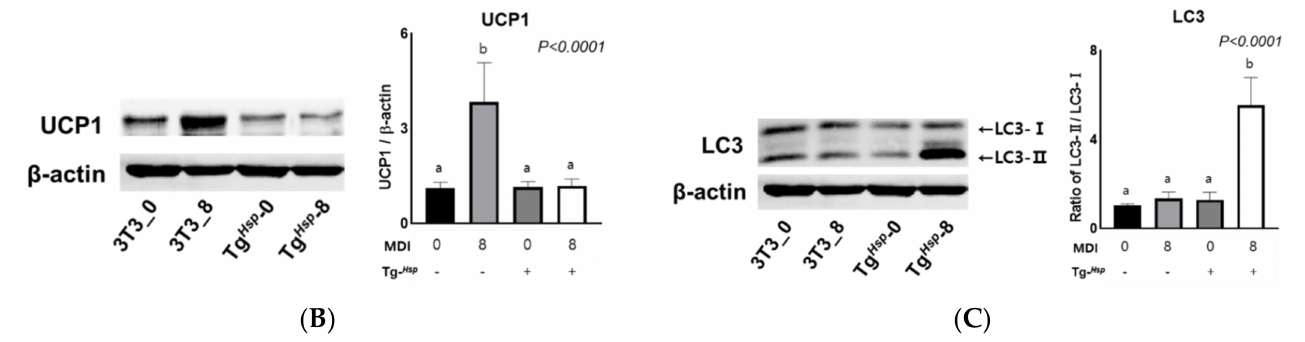
Figure 4. OCR in 3T3 − L1 and Tg Hsp cells ( A ), and expression of UCP1 in 3T3 − L1 and Tg Hsp cells ( B ); Tg Hsp induced the expression of autophagosomal proteins in 3T3 − L1 and Tg Hsp cells ( C ). To compare the OCR between 3T3 − L1 and Tg Hsp , these two types of cells were measured on Day 8 of differentiation. OCR measurement was confirmed using the Seahorse XF Mito Stress Test Kit. OCR was measured using 1.0 × 10 4 3T3 − L1 cells and 2.0 × 10 4 Tg Hsp cells. Basal respiratory capacity, maximal respiratory capacity, spare respiratory capacity, proton leak, and ATP production were calculated using OCR and are shown as graphs. Data are presented as means ± SDs of five replicates. Means with different superscripts are significantly different at p < 0.05 by a t -test. ( A ) Protein levels for UCP1 ( B ) and LC3 − I and LC3 − II ( C ) were analyzed by Western blotting. The LC3 − II/LC3 − I ratio is shown on the right of graph C . Data are presented as means ± SDs of at least three replicates. Means with different superscripts are significantly different at p < 0.05 by Duncan’s multiple range